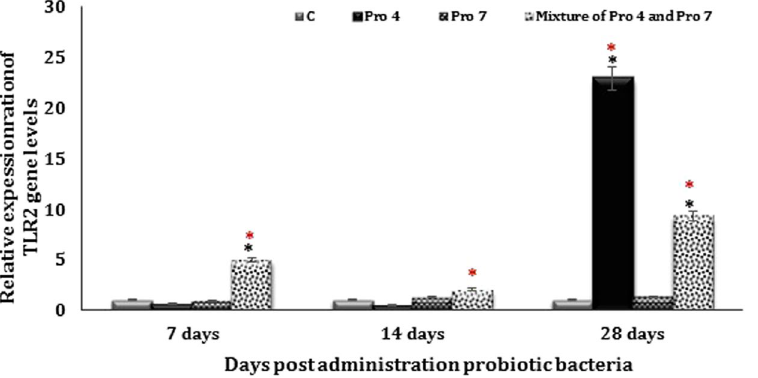
Figure 5. Regulation of TLR2 gene expression in all mice groups following treating with probiotic bacteria. Where C represented untreated group Pro 4 represent group treated with Lactobacillus paracasei/casei , Pro 7 represent group treated with Lactobacillus rhamnosus and mixture of Pro 4 and Pro 7 represent group treated with a mixture of 1:1 from Lactobacillus paracasei/casei and Lactobacillus rhamnosus . Total mRNA was isolated from the intestine of the indicated mouse strains and subjected to TLR2 real-time PCR. ( * ) Significant at p < 0.05 as determined by analysis of variance, comparison was performed using One factor ANOVA test. ( * ) Comparison between controls and tested group. ( * ) Comparison between the treated groups. Every point represents the mean value of three separate tests and the vertical bars denote the 5% percentage around the mean.